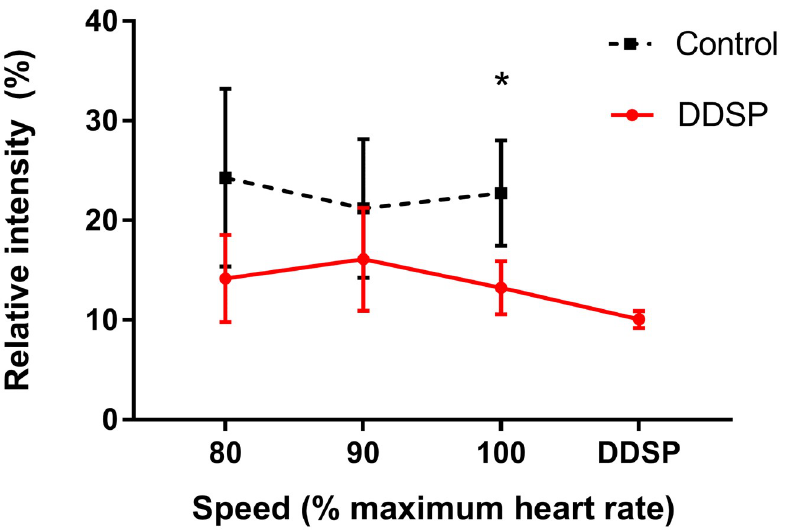
Fig 7. Relative contribution (% of the total intensity) of the high frequency (330–465 Hz) domain to the thyro- hyoid muscles electromyographic activity during exercise. Horses affected by palatal instability and dorsal displacement of the soft palate (DDSP) show a significant lower contribution of the high frequency wavelet domain at the highest exercise intensity interval (HR max100 ). Data expressed as mean ± SD. � , p <